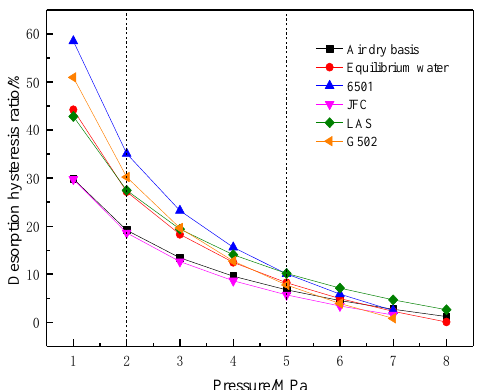
Figure 17. Variation in desorption hysteresis ratio of samples with different